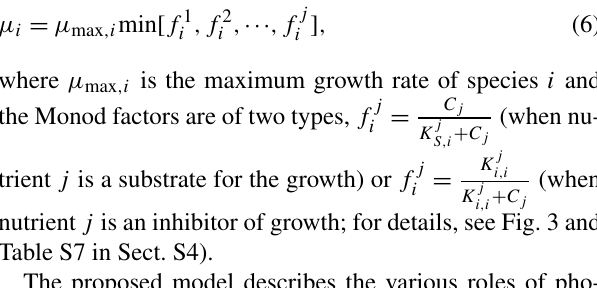
ment: Table S5 in Sect. S4. A graphical summary of micro- bial growth and trophic interactions is given in Fig.